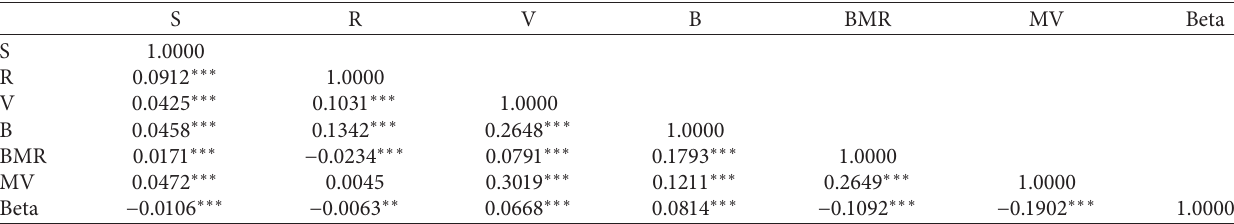
Table 4: Correlation matrix.